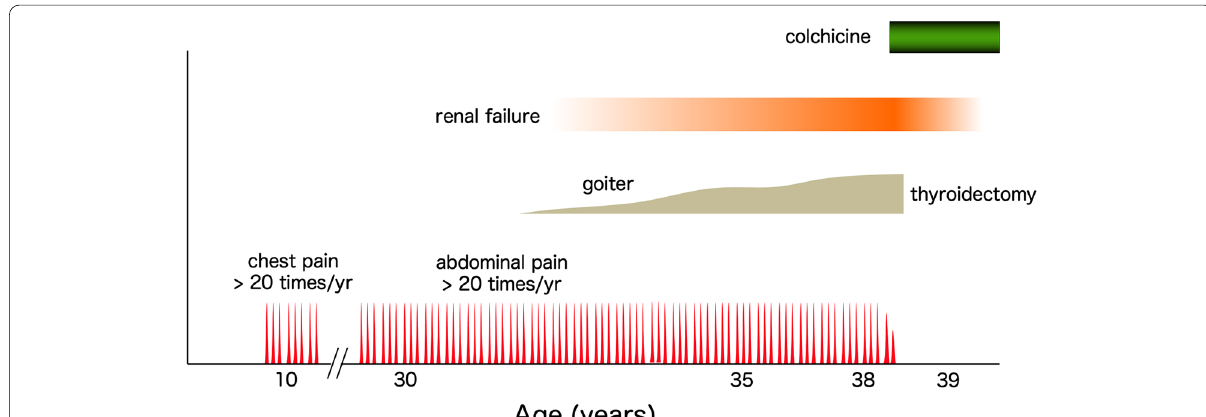
Fig. 2 Diagnostic odyssey for a case with typical FMF. A representative case of typical FMF. The patient started to experience frequent episodes of high fever and chest pain at <10 years old. Similar attacks recurred numerous times over the following years. As he became older, chest pain was replaced by abdominal pain. The final diagnosis was made when renal dysfunction was identified at the time of thyroidectomy for goiter. Both renal dysfunction and goiter were later confirmed to be due to amyloidosis. After initiation of colchicine, the long-lasting episodes of fever and pain rapidly